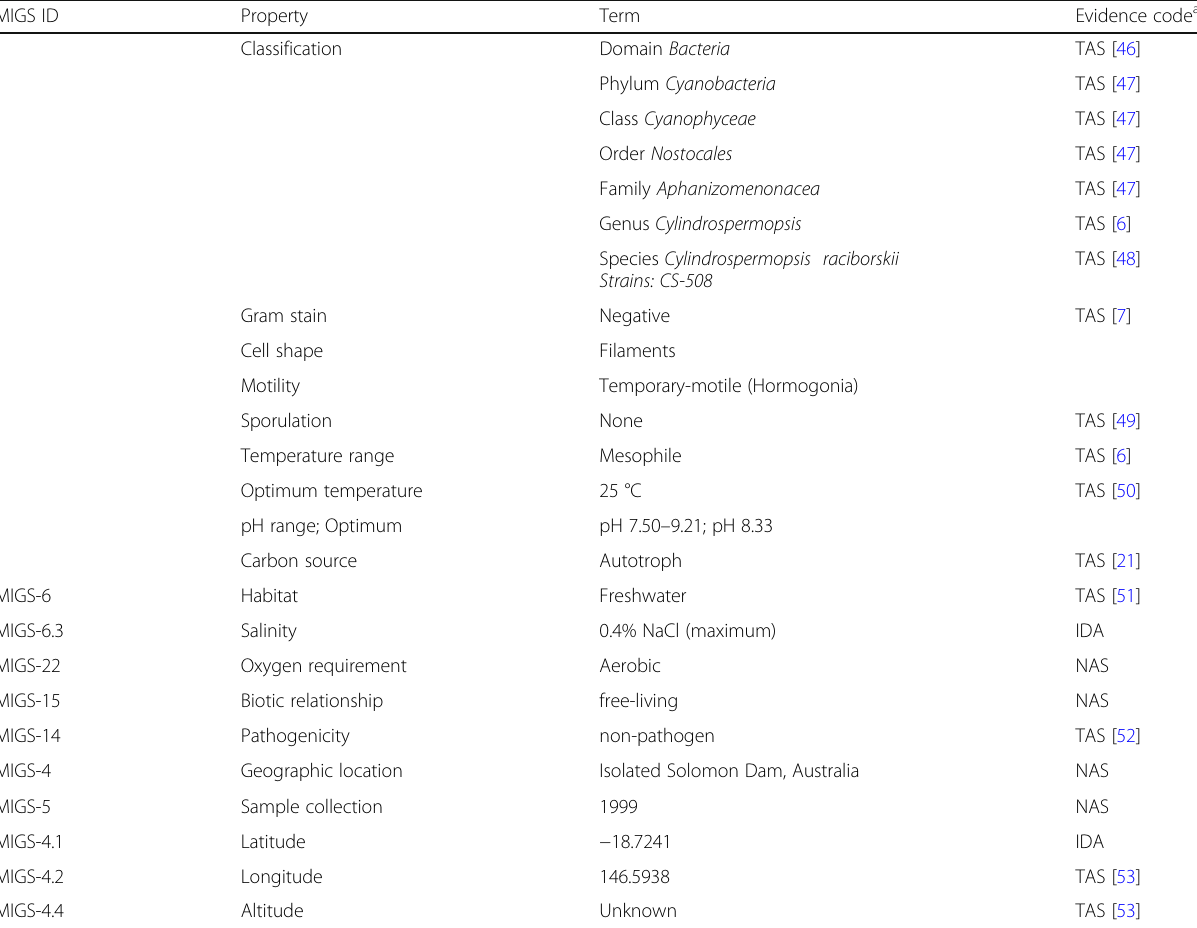
Table 1 Classification and general features of C. raciborskii strain CS-508 according to MIGS designation [45] MIGS